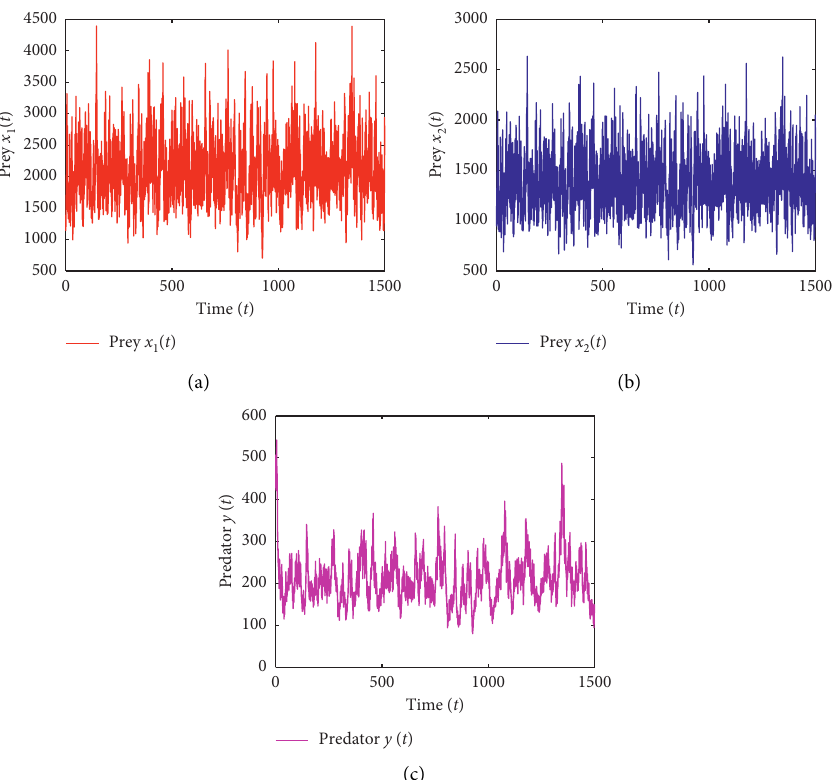
Figure 4: The trajectories of stochastic model (5) with σ 2 and (c) predator y ( t ) .